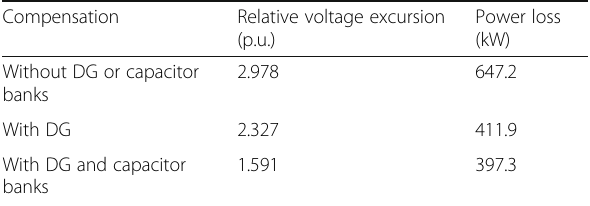
Table 2 Indices before and after compensation